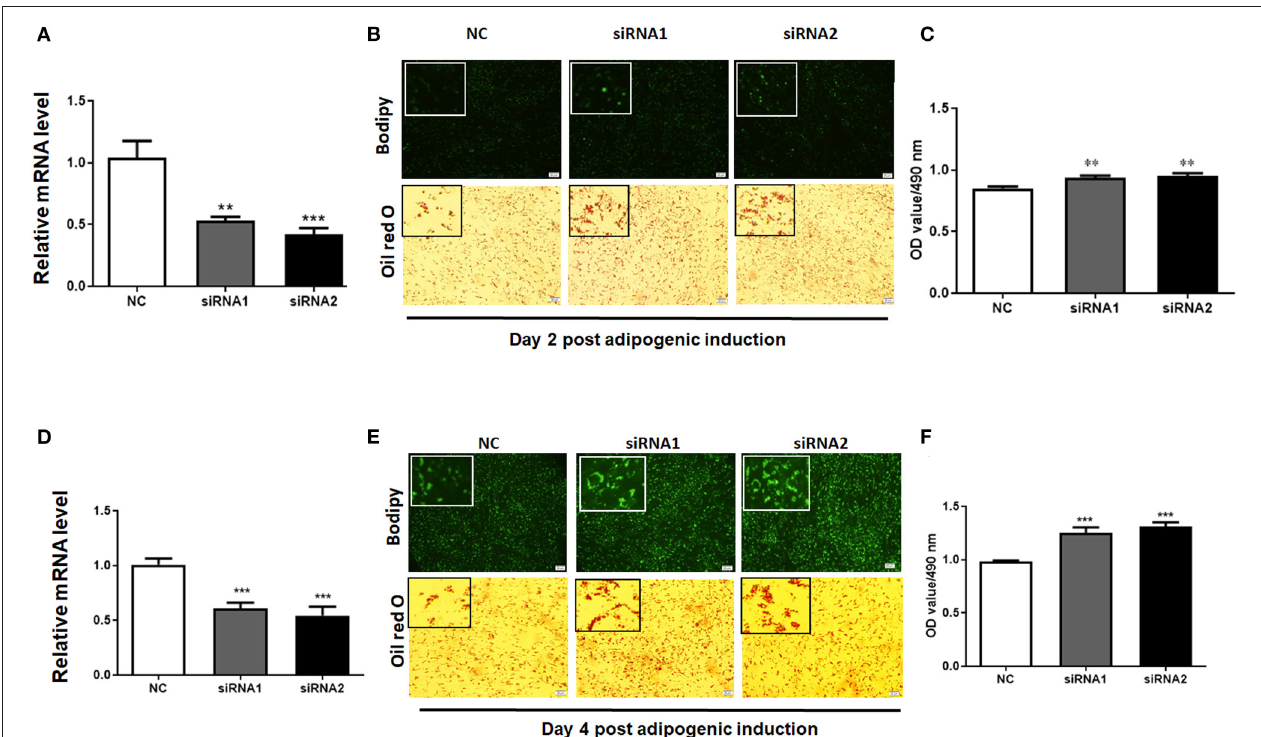
FIGURE 3 | Knockdown of LKB1 promotes goat intramuscular adipocyte lipid accumulation. (A,D) The knockdown efficiency of LKB1 at day 2 (A) and day 4 (D) post-adipogenic induction ( n = 6). (B,E) The bodipy and oil red O staining between control and siRNAs treatment intramuscular adipocyte cells. (C,F) The quantitative analysis of lipid accumulation in the negative control (NC) and siRNAs transfected groups was indicated by the OD value of oil red O dye at 490nm at day 2 (C) and day 4 (F) after adipogenic induction ( n = 6). ** P < 0.01, *** P < 0.001, compared to that of NC. Scale bar: 100 µ m. LKB1, liver kinase